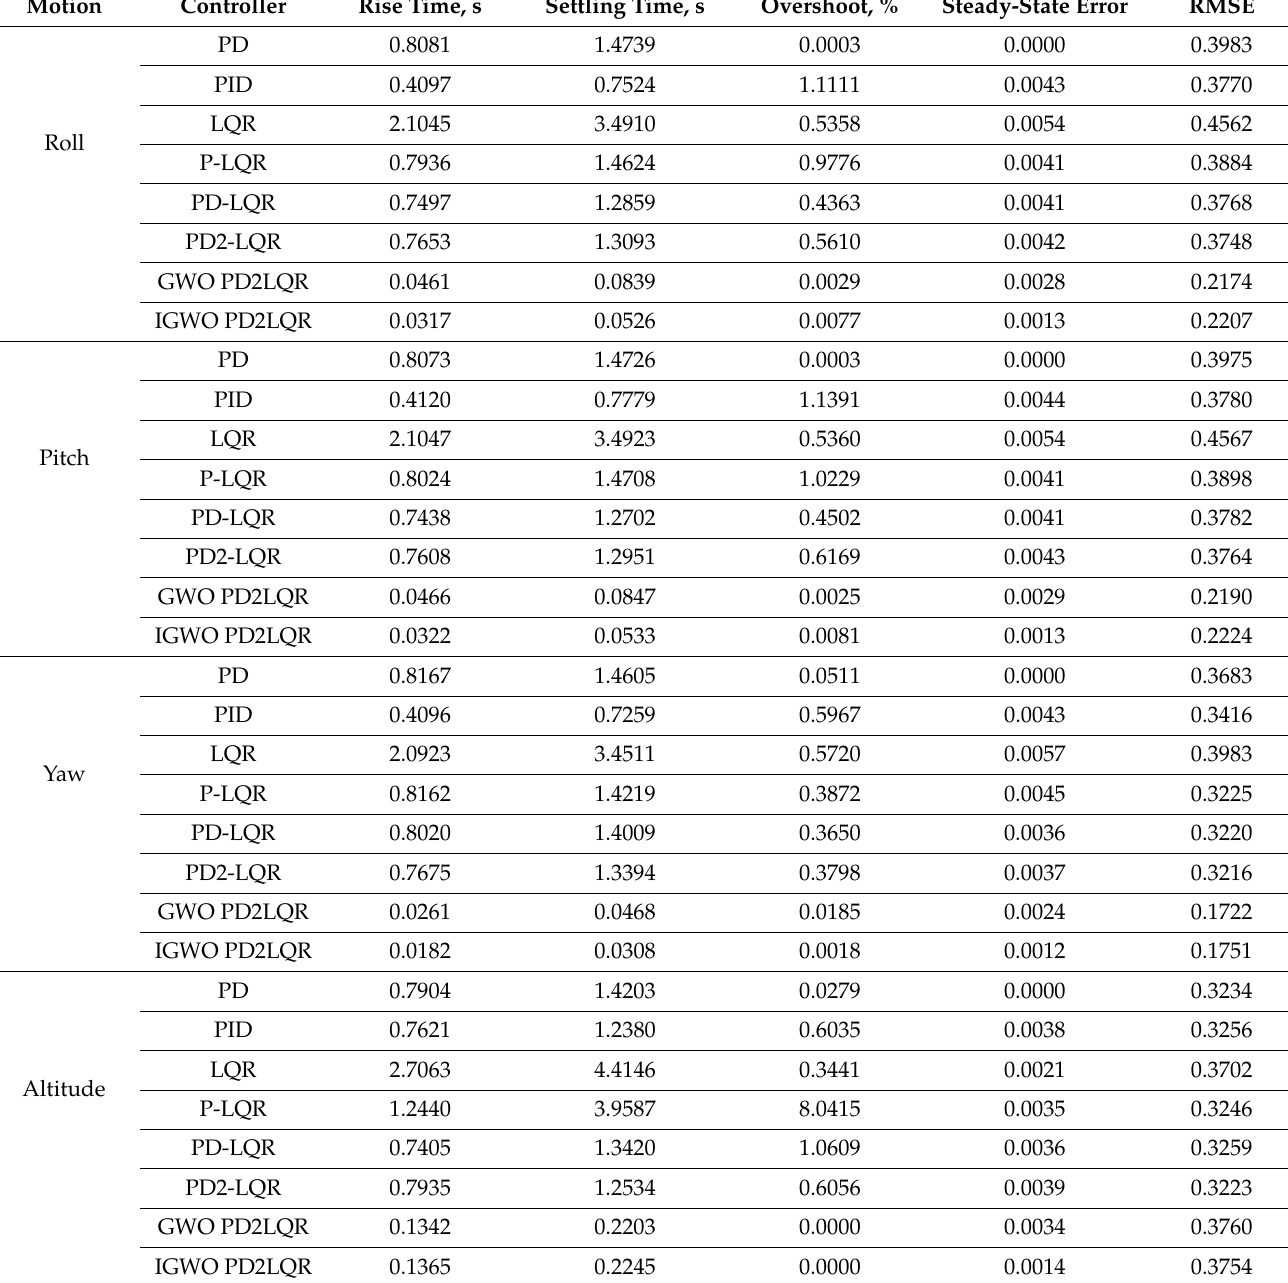
Table 3. Performance comparison of the controller (in